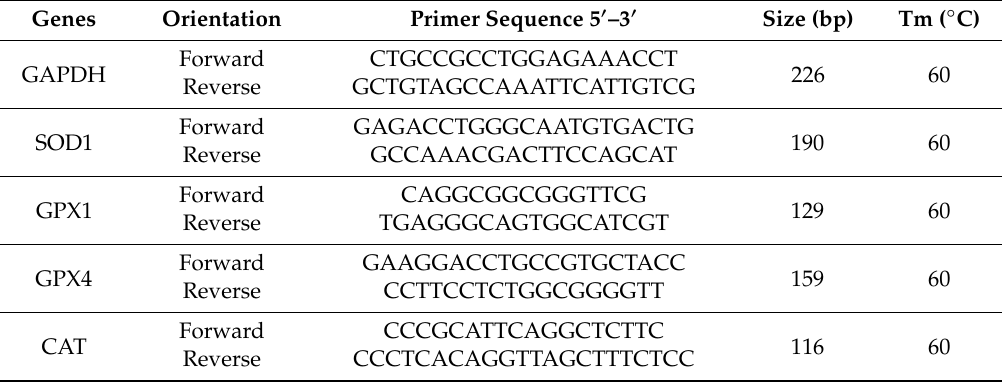
Table 2. The primer sequences for qRT-PCR of antioxidant relative mRNA expression of jejunum and ileum mucosa and liver in weaned pigs.